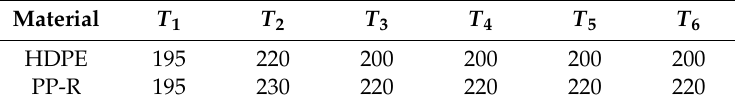
Table 3. Temperature profiles in ◦